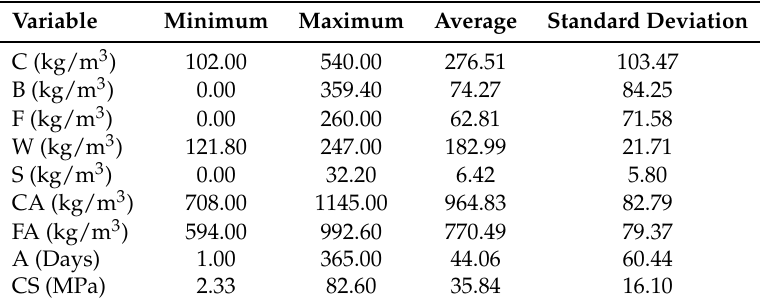
Table 1. The statistical values of the dataset variables.